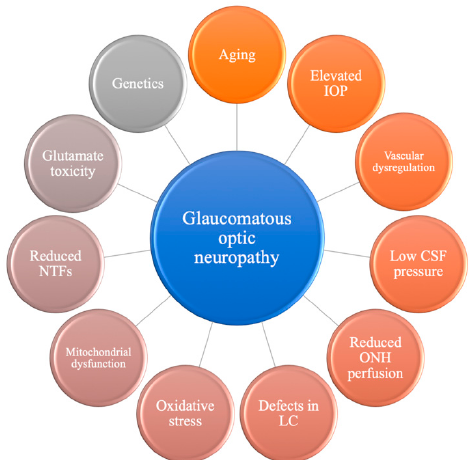
Figure 1. Overview of multifactorial mechanisms contributing to the development of glaucomatous optic neuropathy. CSF, cerebrospinal fluid; IOP, intraocular pressure; LC, lamina cribrosa; NTFs, neurotrophins; ONH, optic nerve head.